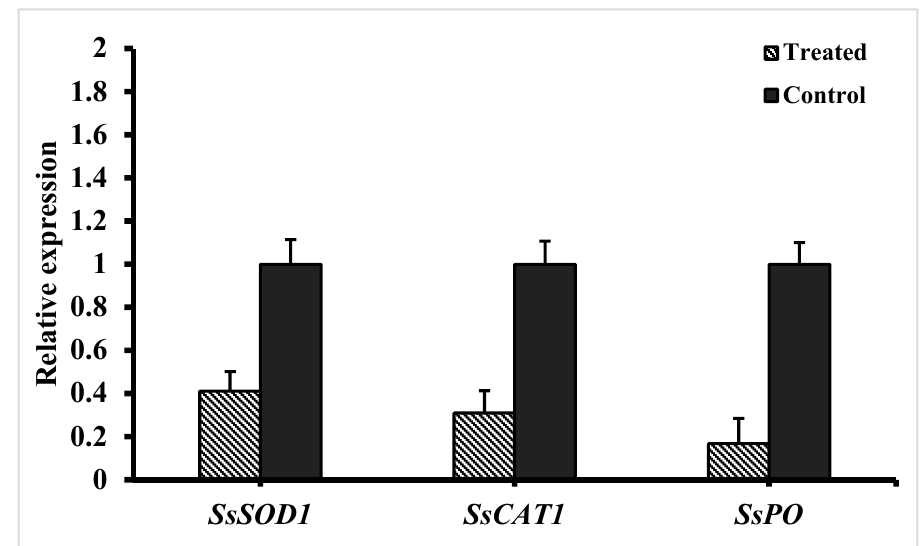
Figure 7. Expression analysis of ROS-scavenging genes in S. sclerotiorum mycelium after treatment with fengycin for 5 h. Mean values were analyzed and separated by Tukey’s HSD test at p ≤ 0.05 after one-way ANOVA. Error bars represent standard error ± SE of the mean.